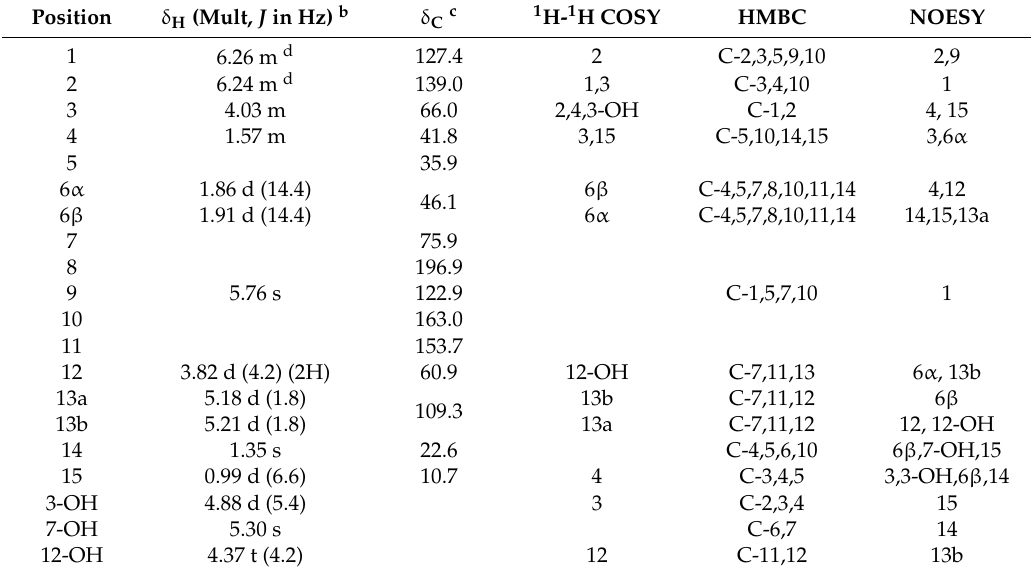
Table 1. NMR spectroscopic data for compound 1 (DMSO- d 6 ) a